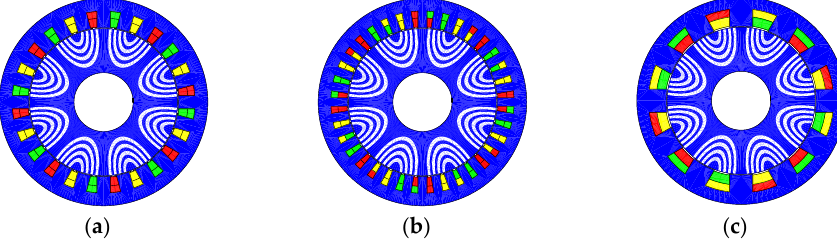
Figure 4. Sample machine geometries ( a ) ISDW ( p = 4, Q s = 24); ( b ) FSDW ( p = 4, Q s = 36); ( c ) FSCW ( p = 4, Q s = 12, n l,w,s = 2). Table 2. Sample machine characteristics.